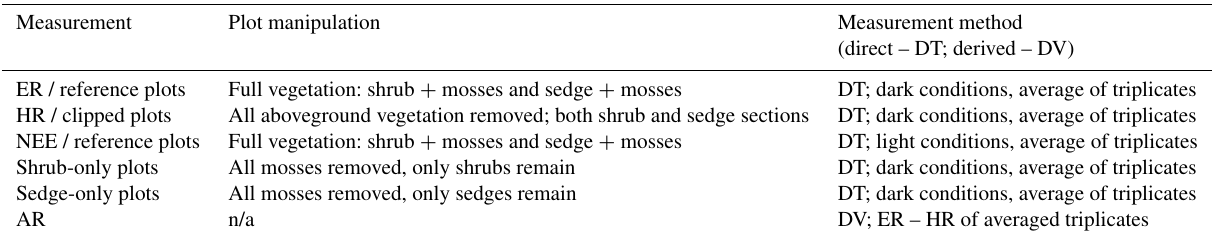
Table 1. Manual chamber setup with descriptions of manipulations and reported measurements. Measurement Plot manipulation Measurement